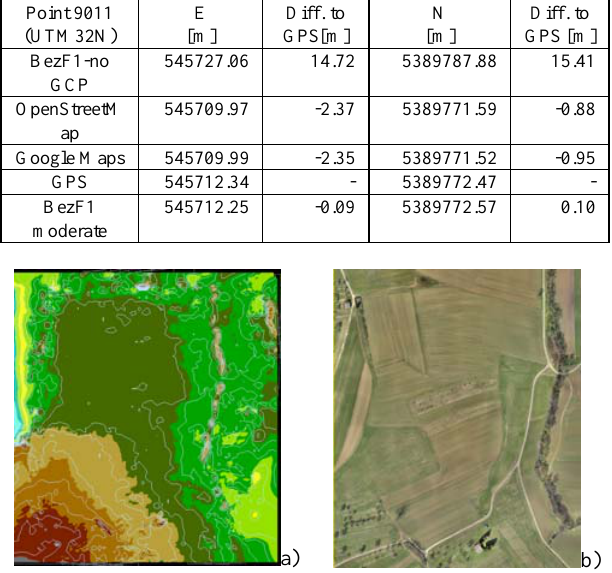
Figure 6: BezF1 with moderate # of GCPs. a) DSM BezF1, b) Orthomosaik